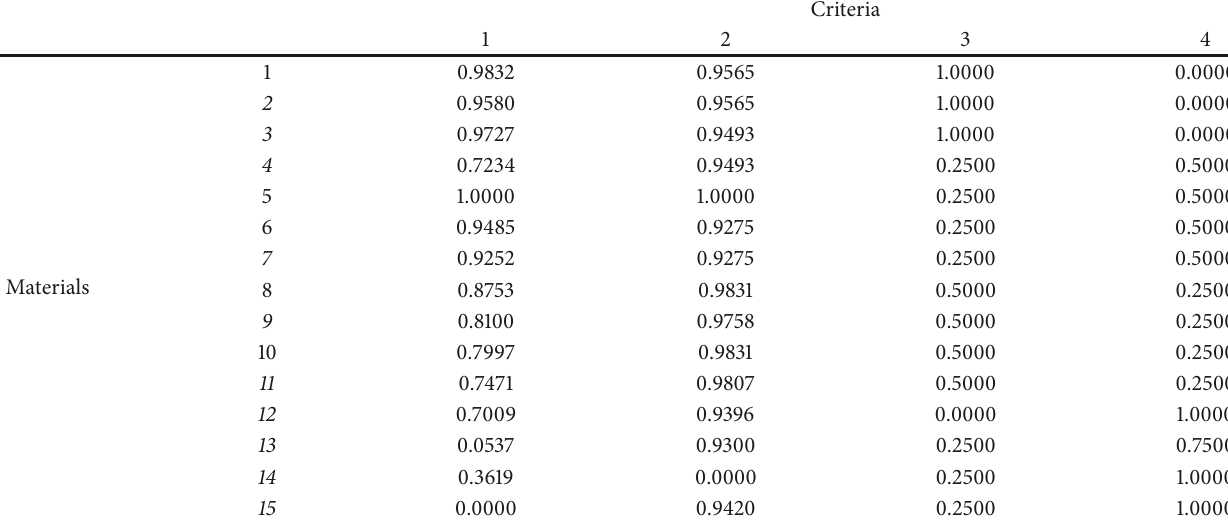
Table 4: Normalized decision matrix for the material selection problem.